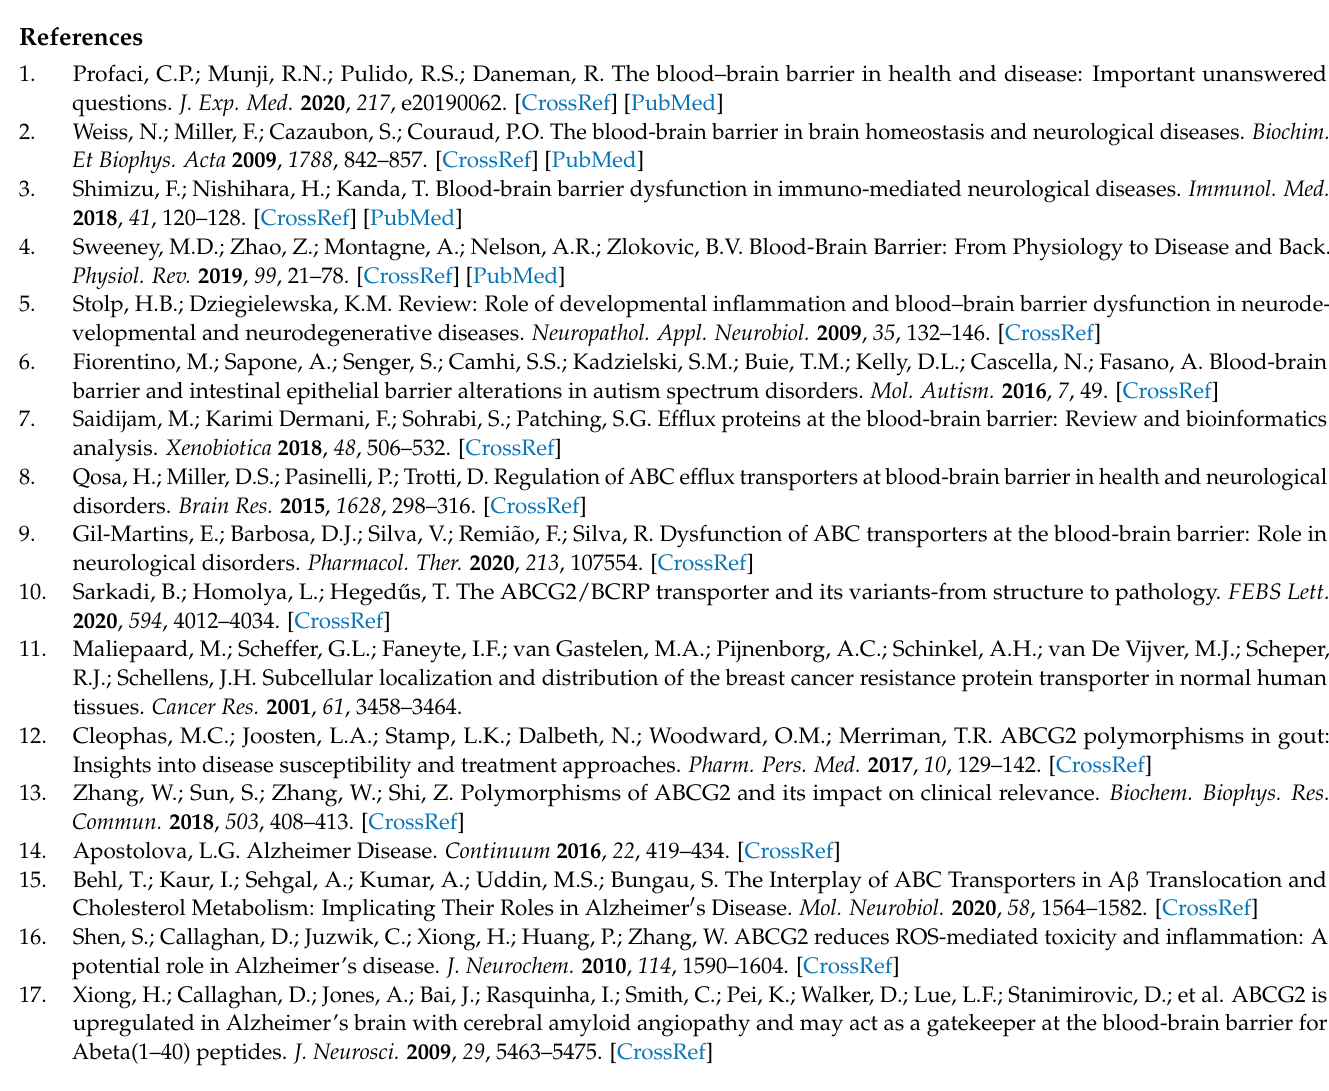
bisphenol exposure, Figure S2: ABCG2 expression, Figure S3: Root-mean-square deviations (RMSDs) to previously reported BWQ binding position, Figure S4: Best predicted docking positions, Figure S5: Predicted BCRP binding affinities, Figure S6: Schematic overview of the three protocols